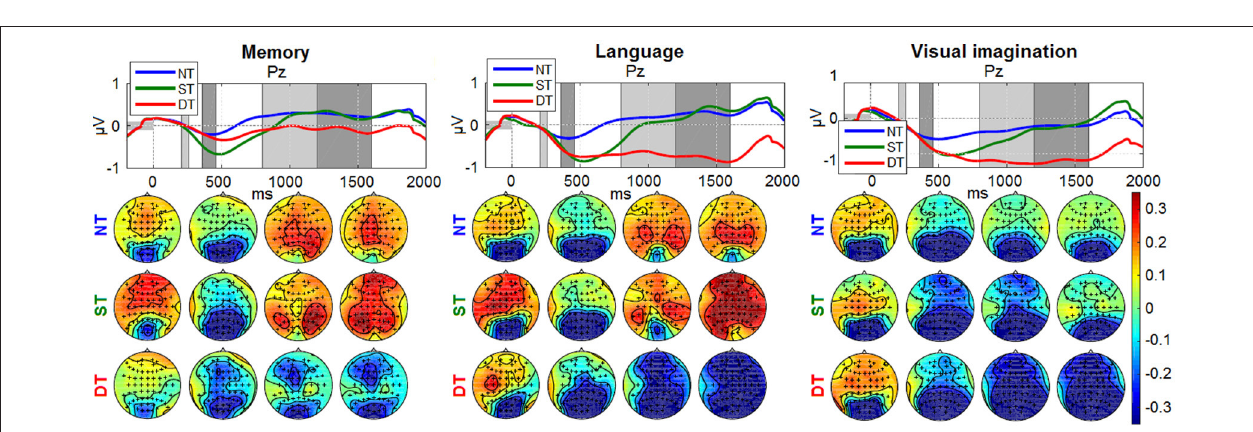
FIGURE 8 | Grand-average ERDs on 8–14 Hz for all processing levels (NT, ST, DT) at electrode Pz. The baseline interval is represented with a gray horizontal bar, equivalent to 200 ms of pre-stimulus interval. The amplitude range was chosen the same for all graphs, as − 1 to 1 µ V for the time evolution and − 0.35 to 0.35 µ V for the scalp distributions. The timing intervals for the scalp plots are: 210–260, 360–460, 800–1,200, 1,200–1,600 ms.